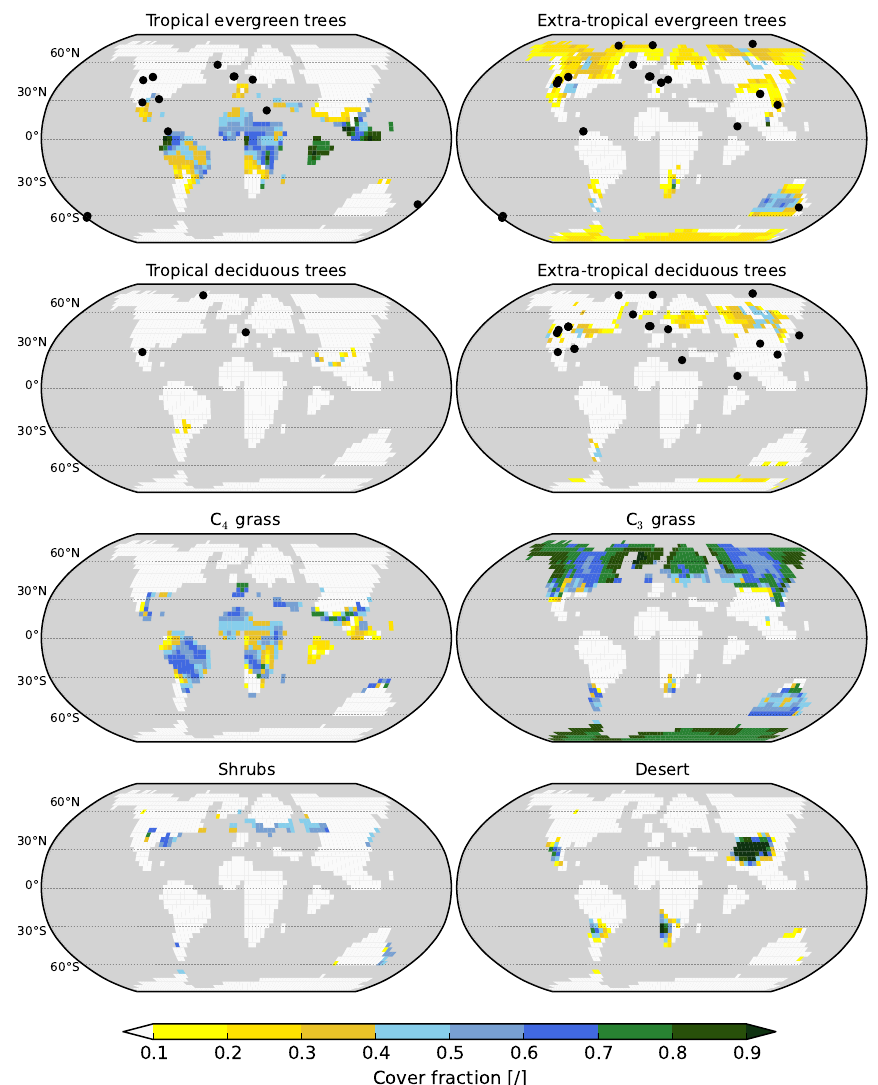
Figure 2. Simulated vegetation cover in the DE d simulation and reconstructed vegetation based on the flora collection by Utescher and Mosbrugger (2007). Locations where the diversity of the respective PFT in flora collection exceeds 10% are